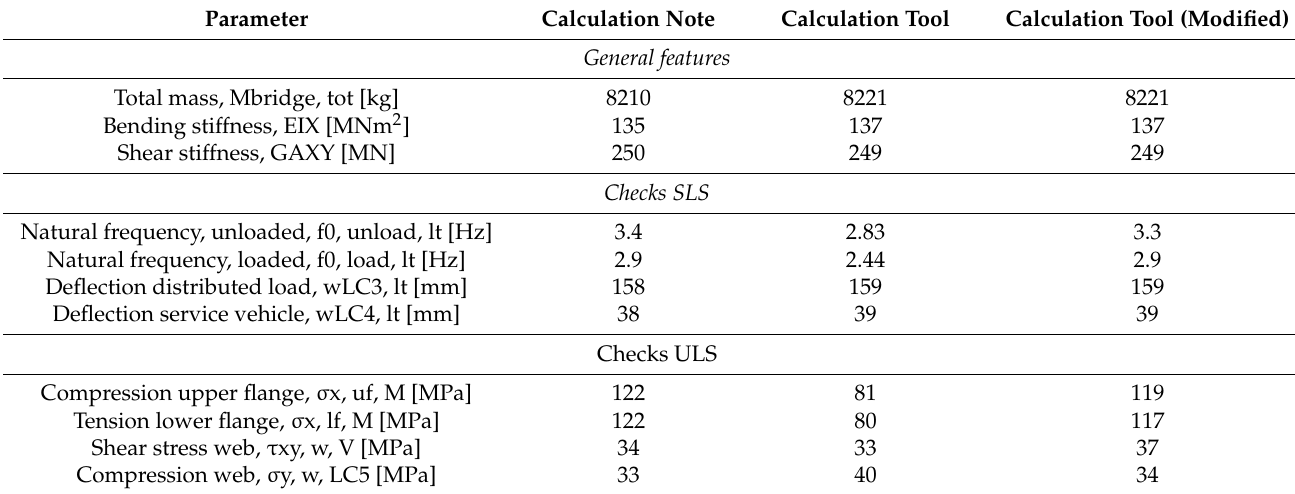
Table 2. Comparison between the calculation note and the (modified) calculation tool for the simply supported FRP footbridge in